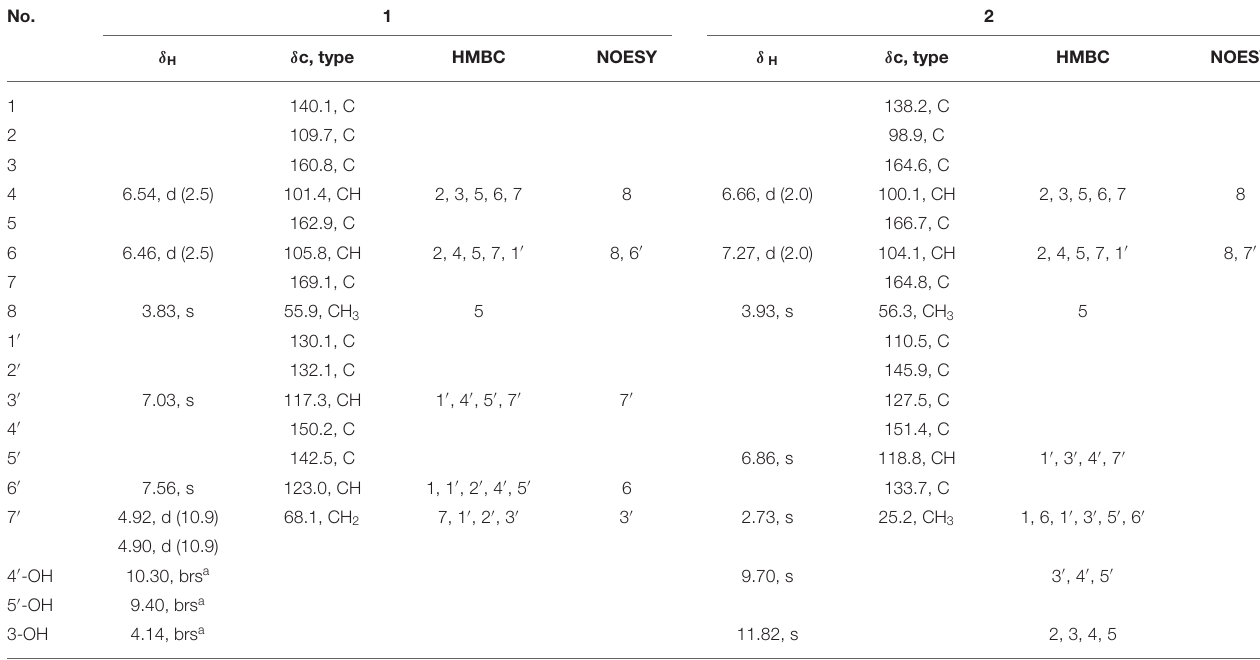
( Supplementary Figure 1 ). Analysis of the 13 C NMR,